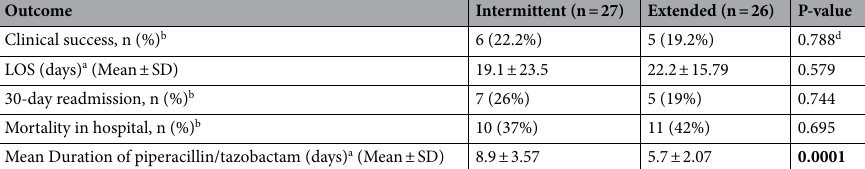
Table 2. Clinical and microbiological outcomes. Results are expressed as mean ± SD or number (%) and were compared using a independent T-test, b chi-square test, c Mann- Whitney U test, d Fisher’s exact Test. P-value ≤ 0.05 is considered statistically significant. LOS Length of Stay. Significant P-values are in